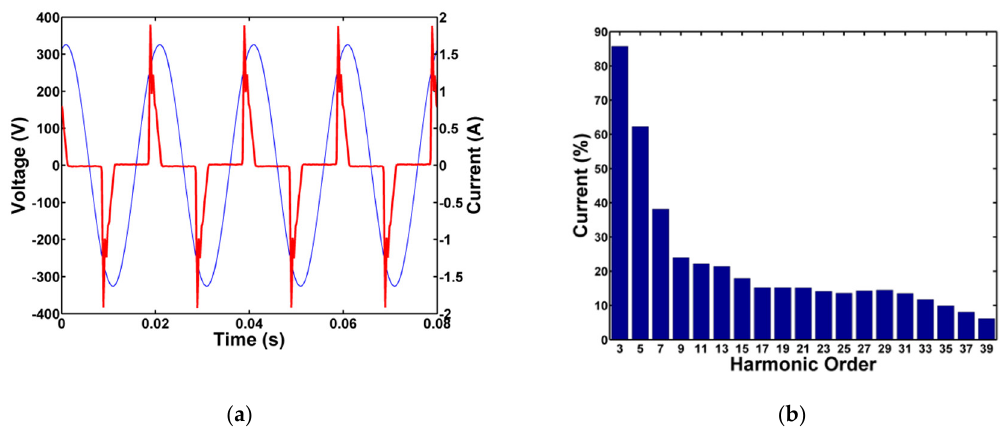
Figure 5. Waveforms of instantaneous values of current and voltage ( a ) for luminaire marked as LUM3 and ( b ) current harmonic spectrum.